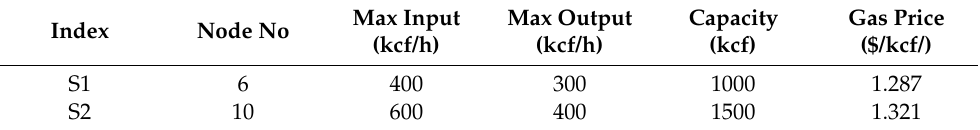
Table A3. Parameters of gas storages.